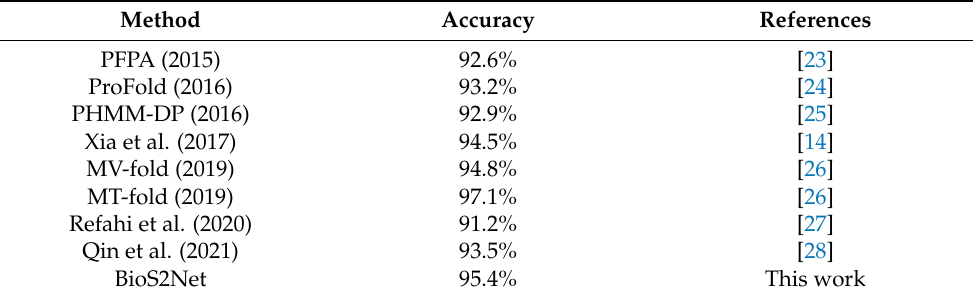
Table 2. Comparison with the different strategies for solving the protein fold recognition problem on the eDD